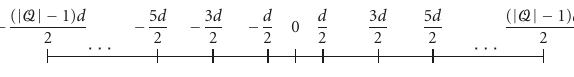
Figure 5: Signal constellations for | Q |